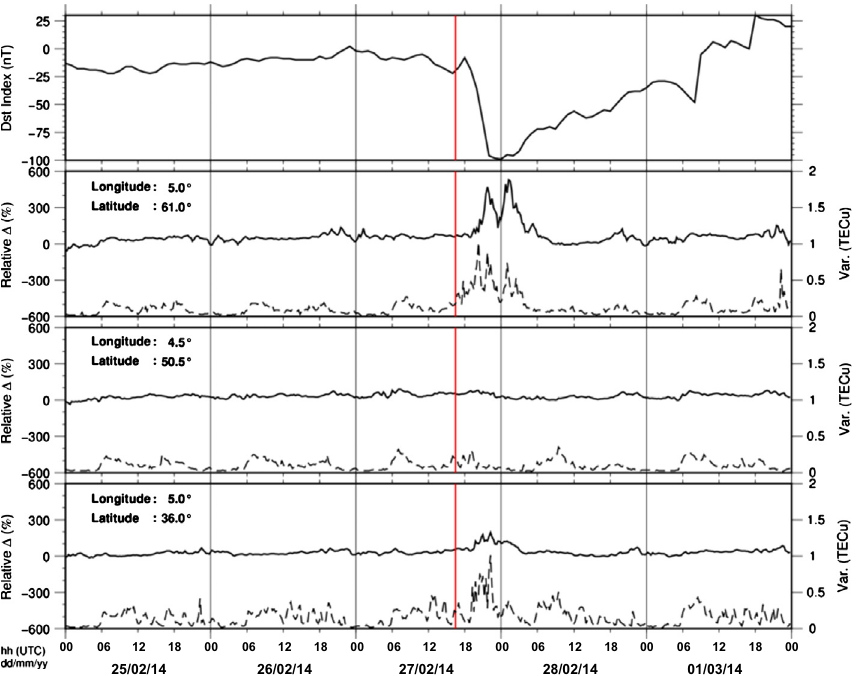
Fig. 7. Dst index and ROB-TEC products for the period February 25 to March 1, 2014. The red line is the storm onset of the moderate geomagnetic storm on February 27. Top: the Dst index as delivered by the WDC Kyoto Observatory. Bottom: the three time-series extracted from ROB-TEC maps at three different geographic locations shown on Figure 4. The bold line represents the relative differences between the ROB-TEC values and the median from the 15 previous days. The dashed line is the variability of the vTEC estimated in